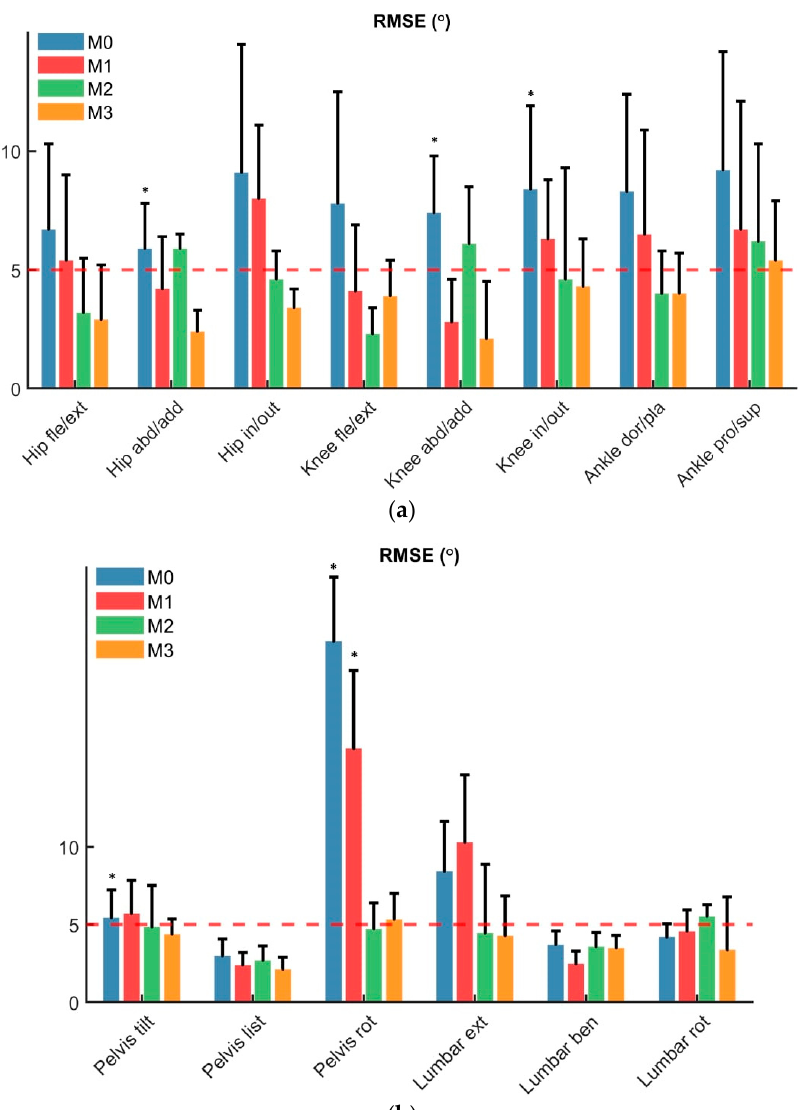
Figure 4. Subjects RMSE (mean ± SD) for InCap joint kinematics during walking compared to clinical threshold of 5.0 deg (red dotted line). Differences between the developed methods (M0—blue, M1—red, M2—green, M3—orange) across the joint-planes ( a ): Hip flexion/extension, hip abduction/adduction, hip internal/external rotation, knee flexion/extension, knee abduction/adduction, knee internal/external rotation, ankle dorsiflexion/plantarflexion, ankle pronation/supination; ( b ): pelvic tilt, pelvic list, pelvic rotation, lumbar extension, lumbar bending, lumbar rotation. * p ≤ 0.05. M0: OpenSense standard pipeline, M1: functional hip abd-adduction motion calibration, M2: functional PCA walking calibration, M3: functional hip abd-adduction and walking PCA calibration.